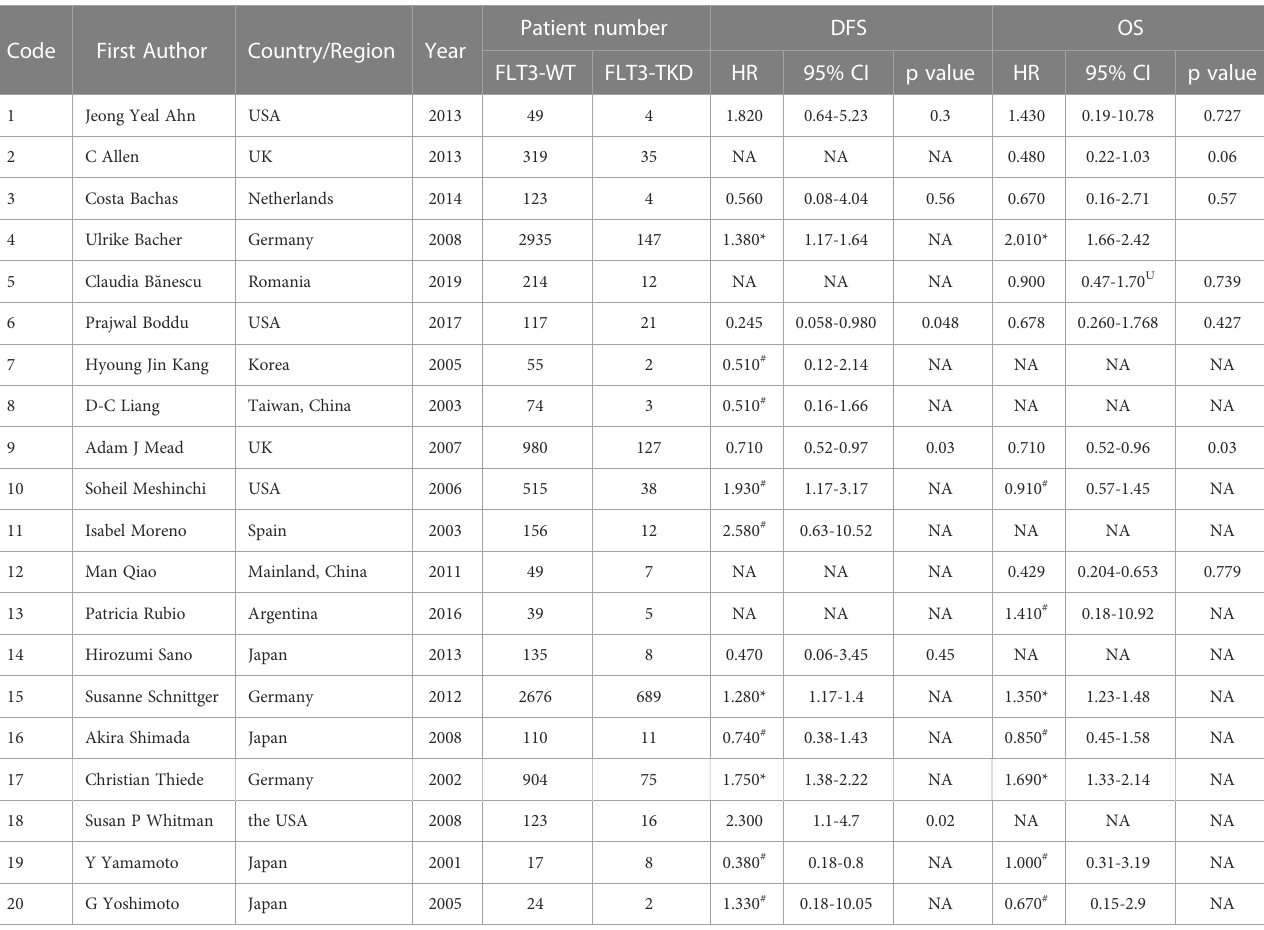
TABLE 1 Characteristics of studies included in the meta-analysis.